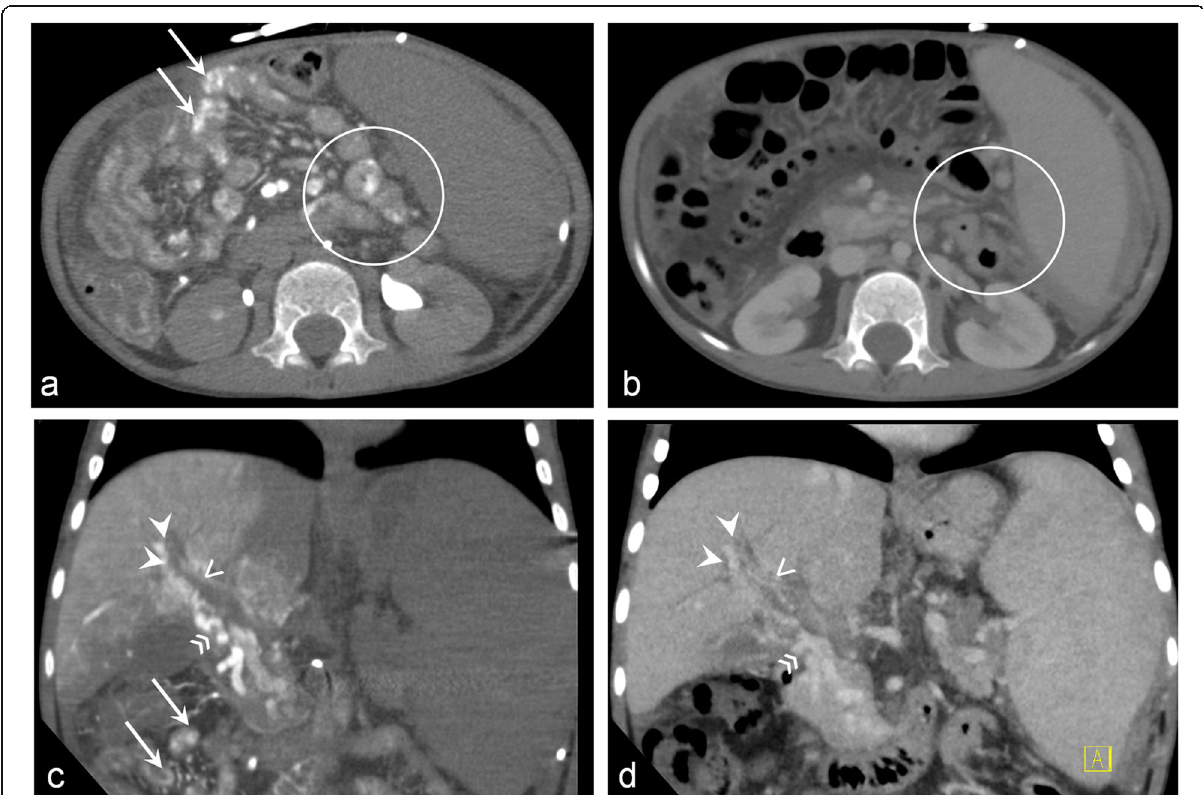
Fig. 3 Comparison of computed tomography (CT) arterioportography (AP) ( a , c ) with standard CT after intravenous contrast injection (portal venous phase: b , d ) in a 6-year-old male patient with portal vein thrombosis. Axial ( a ) and coronal ( c ) images of CT AP after contrast injection into the superior mesenteric artery allow to clearly detect multiple jejunal varices (arrows and circle) and portal biliopathy (arrowheads and open arrows: multiple small peribiliary collaterals, irregular and dilated bile ducts). Axial ( b ) and coronal ( d ) standard CT in the portal venous phase after intravenous contrast injection performed 2 weeks before CT AP does not detect any jejunal varices; evidence of portal biliopathy is lower than that provided by CT